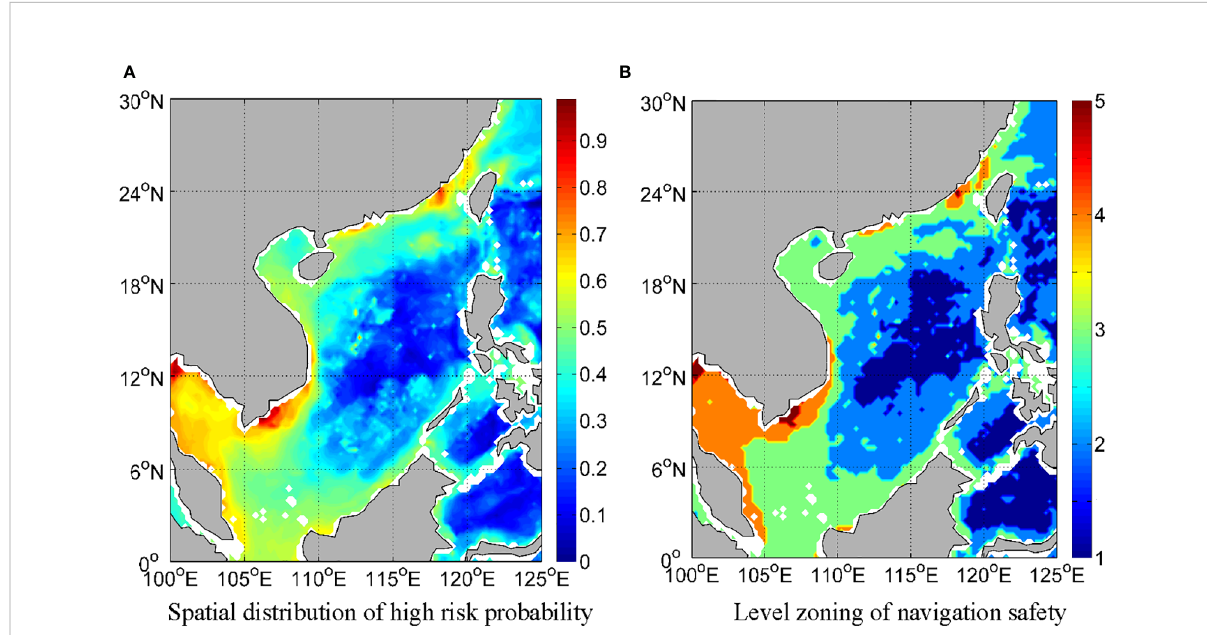
FIGURE 6 Navigation safety assessment on October 4th. [Spatial distriution (A) ; Level zoning (B)